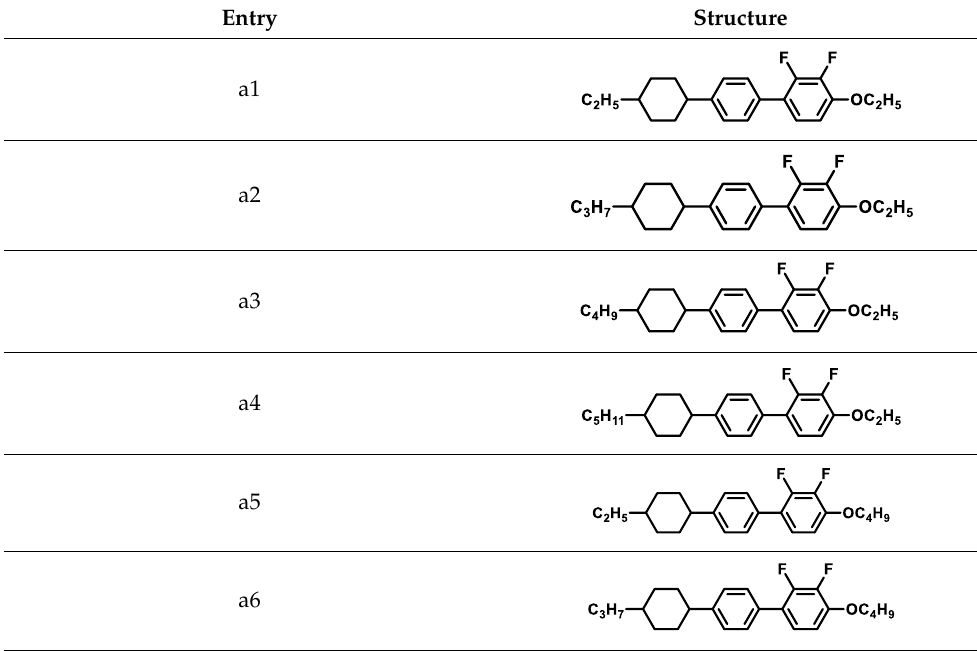
Table 2. The structure of negative dielectric anisotropy compounds (Type A).